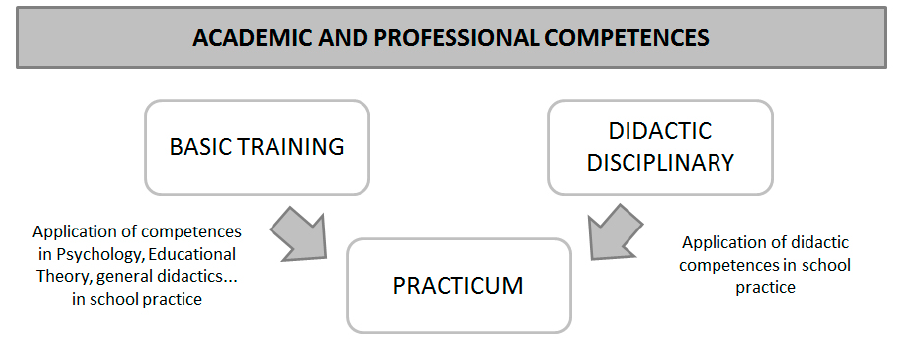
Figure 2. Relations between competences of the ECI/3854/2007 Order.